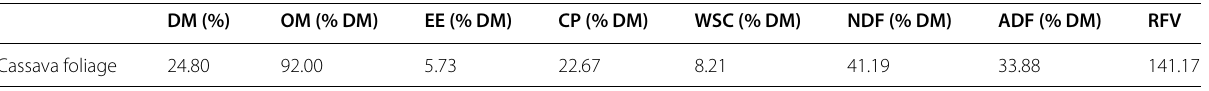
Table 2 Chemical composition of